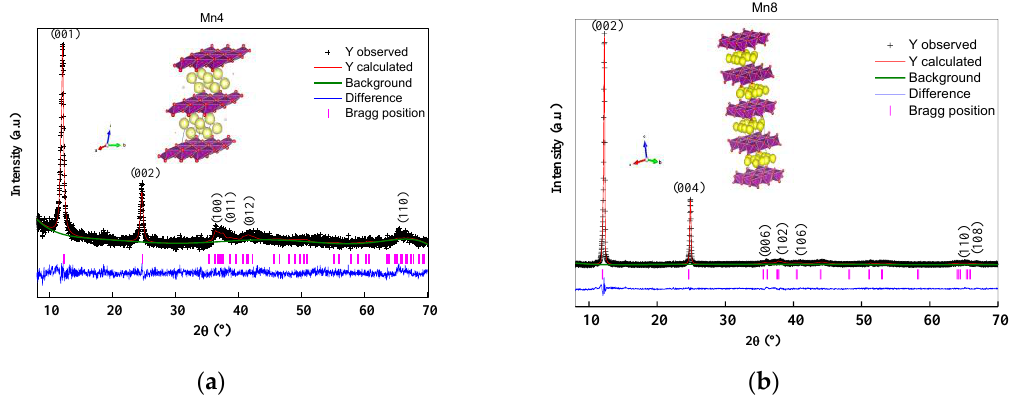
Figure 2. Rietveld refinement results for ( a ) Mn4, and ( b ) Mn8. The insert shows the polyhedral structure of the triclinic and hexagonal birnessite for ( a ) Mn4, and ( b ) Mn8 respectively.